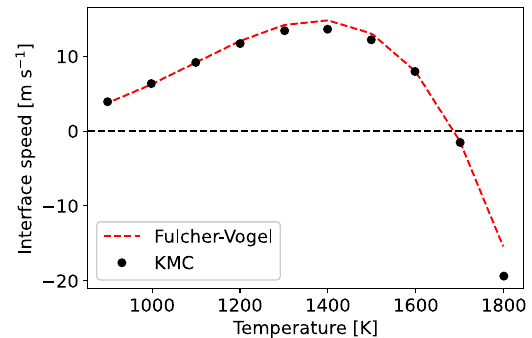
Fig. 3 Calibration of KMC model. Comparison between KMC prediction of the evolution of a Si(001) solid – liquid interface (black dots), calibrated as explained in the main text, and the Fulcher – Vogel expression for Si melting front speed (red dashed line) fi tted from experimental data on crystalline